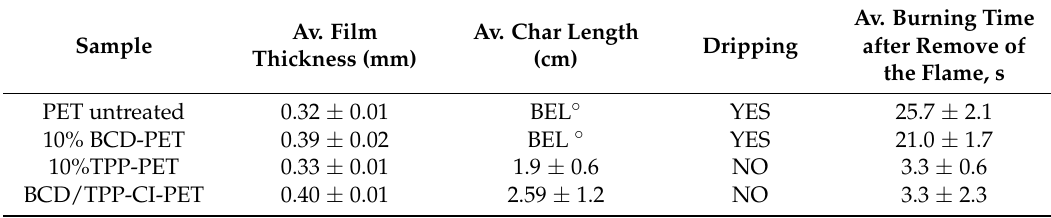
Table 3. Fire retardance performances according to a Modified ASTM D6413: Standard test method for flame resistance of textiles. 10% load of various flame retardants (FR) additives. (data adapted from ref. [50], average of three